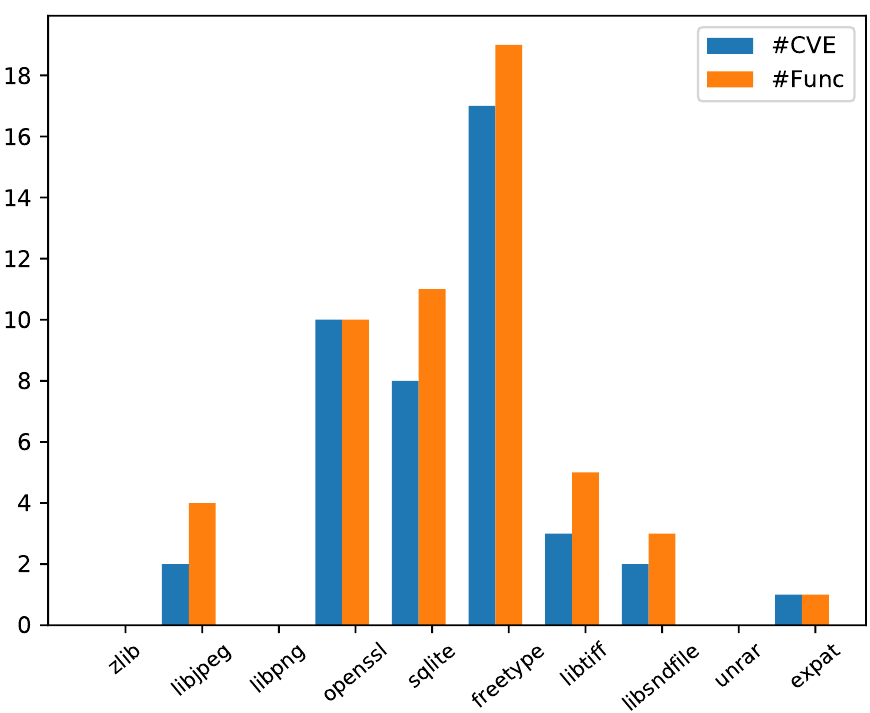
Figure 4. Frequently reused components